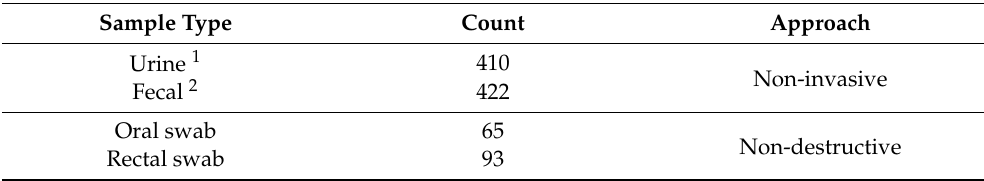
Table 3. Number and sample types included to assess the SYBR Green assay performance on the field collected samples obtained from the Egyptian rousette